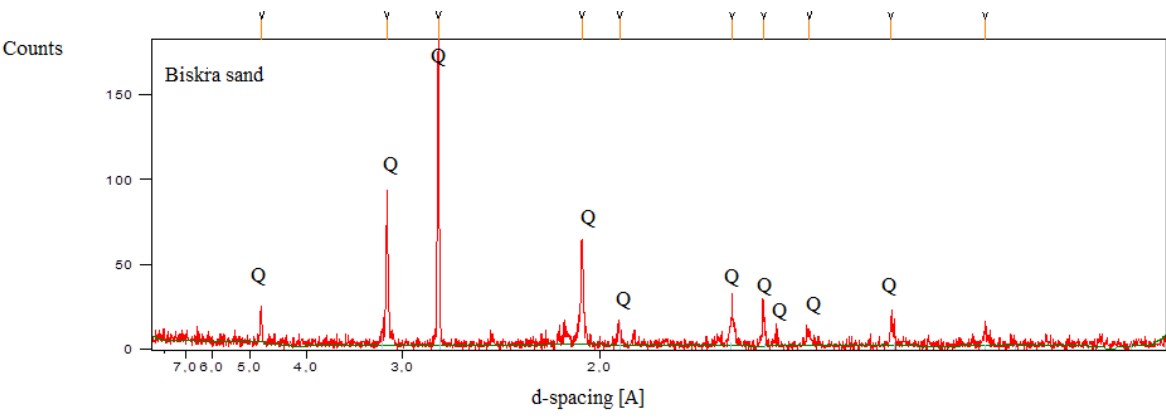
Figure 6: XRD spectrum of Biskra sand.